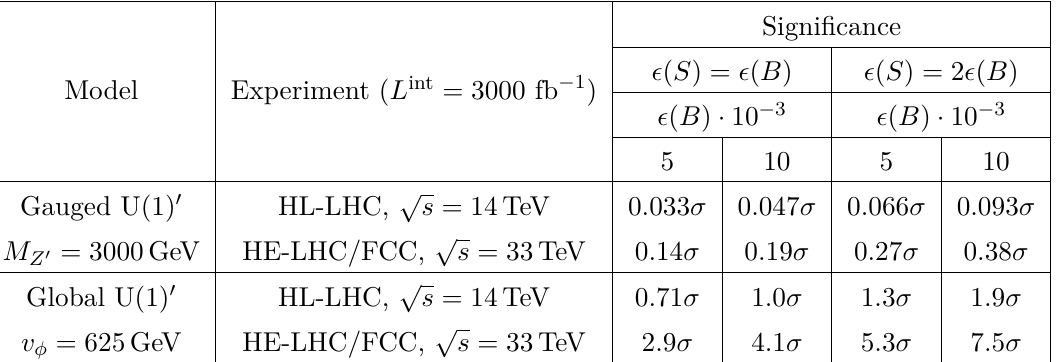
Table 6. Significances for the gg → φ → tT → ttZ signal with M φ = 1250 GeV and the parameter setup given in equation (6.3) for four values of acceptance × selection efficiency: on the left the total signal efficiency is equal to the background one, (cid:15) ( S ) = (cid:15) ( B ) , while on the right it is twice the background one, (cid:15) ( S ) = 2 (cid:15) ( B ) . For each of those cases, we take two background total efficiencies: a conservative (cid:15) ( B ) = 5 × 10 − 3 and an optimistic (cid:15) ( B ) = 10 − 4